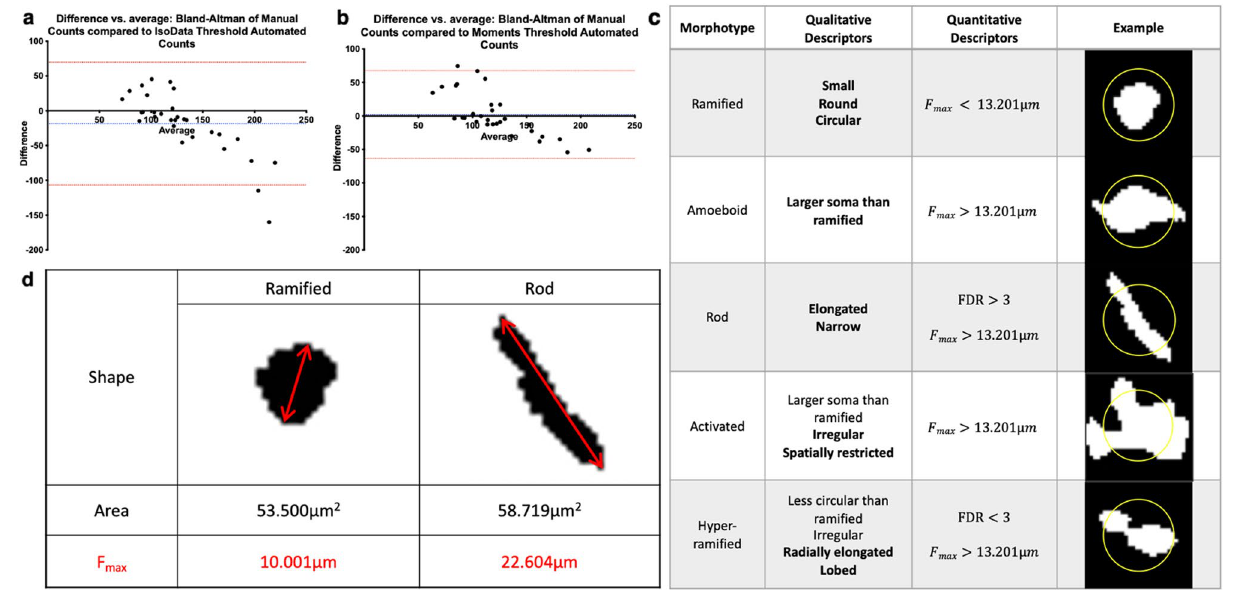
Figure 2. Qualitative and Quantitative Descriptions of Microglia Morphotypes. The Bland-Altmann graphs show the difference between either IsoData ( a ) or Moments ( b ) CBCS cell counts and the manual counts on the y axis, against the average of IsoData or Moments and the manual counts. The dotted lines in blue show the average of differences. That in red show the average ± 1.96 Standard Deviation. For ( c ), literature references 4,10,12,16,30–36 were used to deduce qualitative descriptors of the cell bodies of each microglia